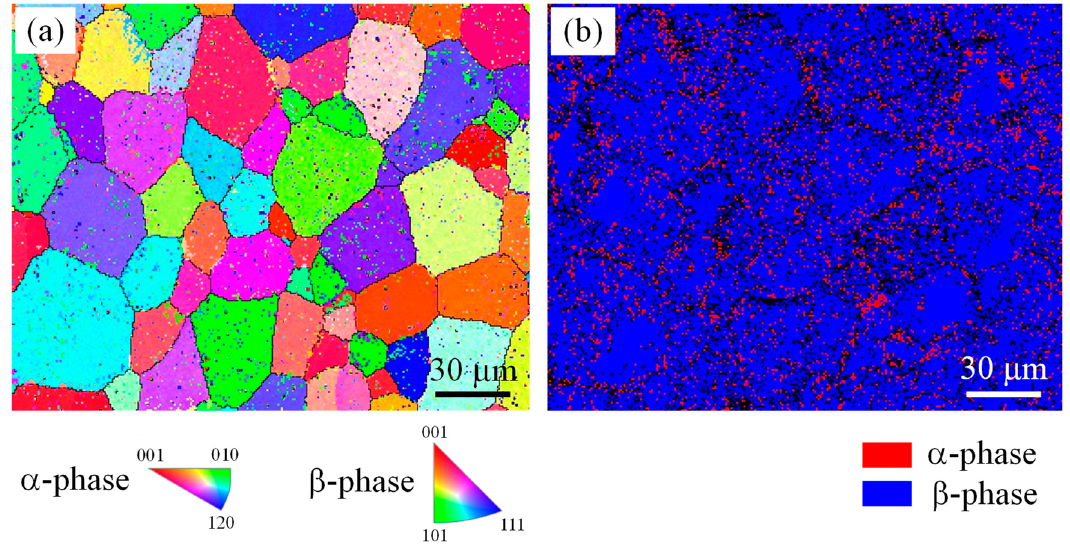
Figure 1. EBSD analysis of microstructure: ( a ) inverse pole figure (IPF) map; ( b ) phase map.